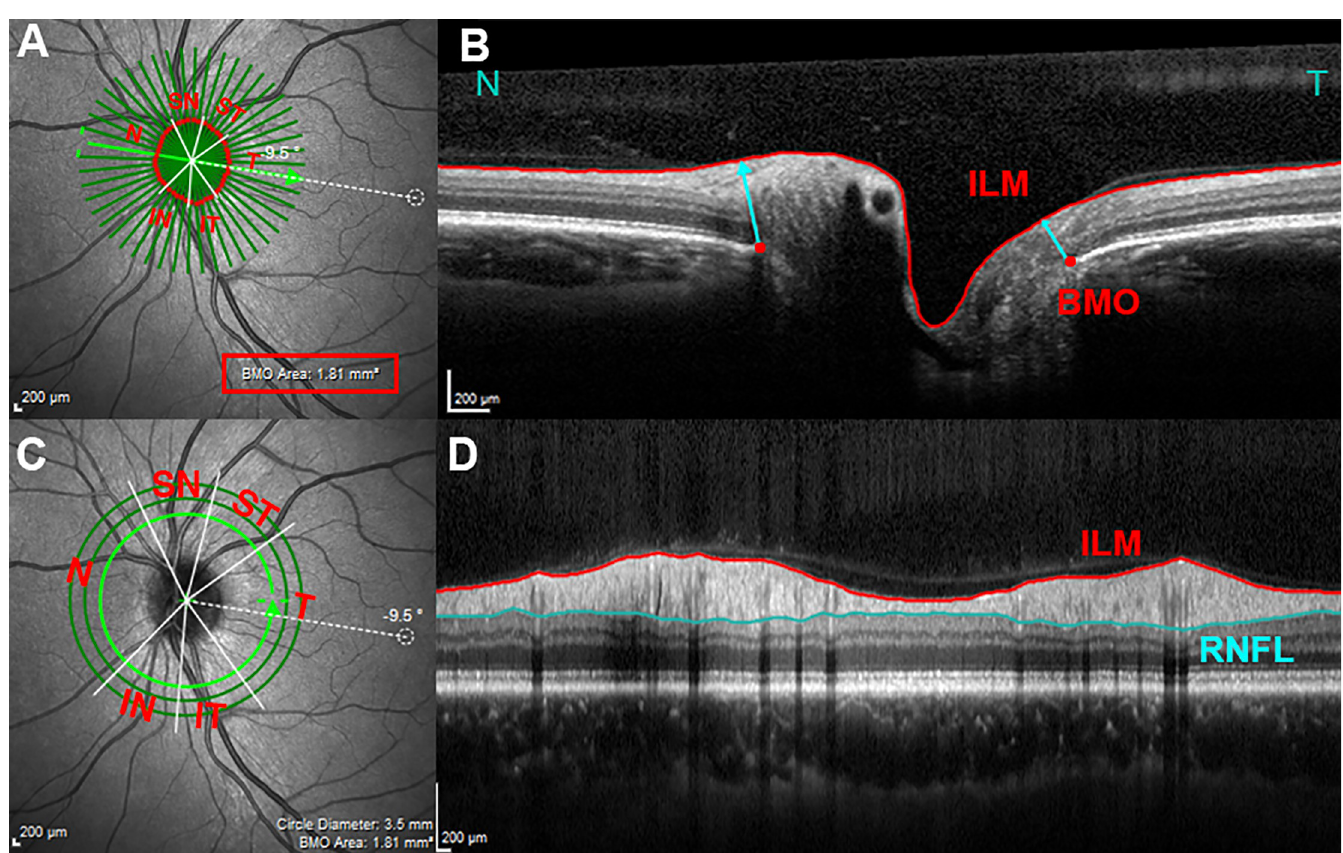
Fig 1. Spectral-domain optical coherence tomography imaging and parameters’ measurements. The infrared image in (A) shows 24 radial B-scans centered on the ONH (dark green radial lines) acquired relative to the orientation of the FoBMO center axis (green arrow connecting the fovea and the BMO center, -9.5˚ in this subject). In (B), one horizontal radial B scan shows MRW measurements. MRW (cyan arrow) is the minimum distance between BMO (red dots) and ILM (delineated in red). Each B scan yield 2 BMO points and 2 MRW measurements, in this example a nasal (N) and a temporal (T) measurement. The 3D coordinates of each of the 48 BMO points are used to fit a spline which derives a closed curve representing the BMO area (1.81 mm in this disc). In (C) the 3.5 mm diameter circular scan (light green circle) centered on the ONH was used for RNFLT measurements. (D) Is the corresponding circular B-scan showing the ILM (red) and RNFL (cyan) delineations. MRW and RNFLT measurements were averaged and analyzed globally and in 6 sectors: ST(superotemporal), SN (superonasal), IT (inferotemporal), IN (inferonasal), T (temporal), and N (nasal), in relation to the FoBMO center axis.